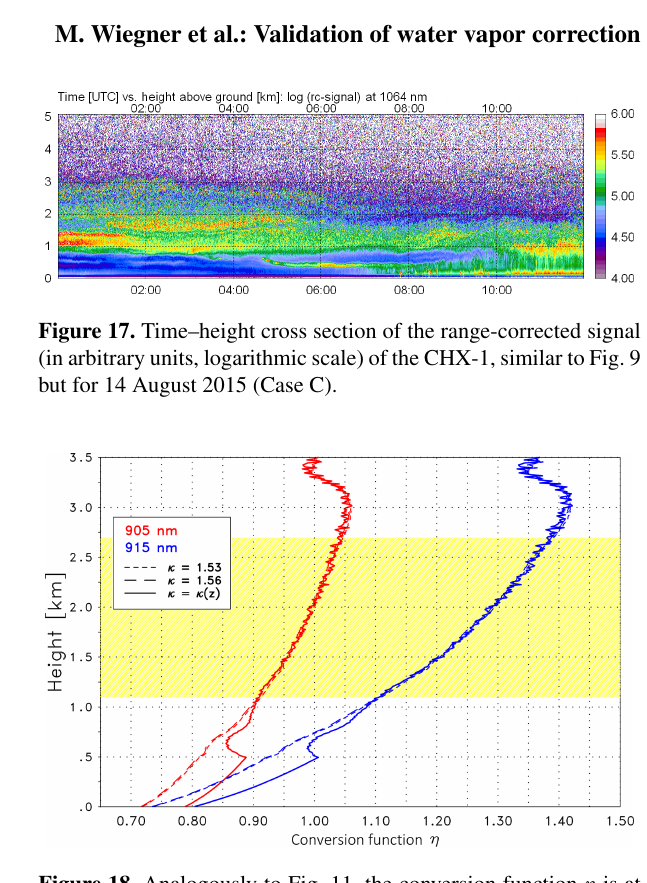
Figure 18. Analogously to Fig. 11, the conversion function η is at 905nm (red) and 915nm (blue). The solid lines are for κ(z) derived from the RALPH measurements; the dashed lines are for a con- stant κ as indicated. The validation range is between 1.1 and 2.7km (yellow area). Measurements are from 14 August 2015, 00:00– 03:00UTC (Case